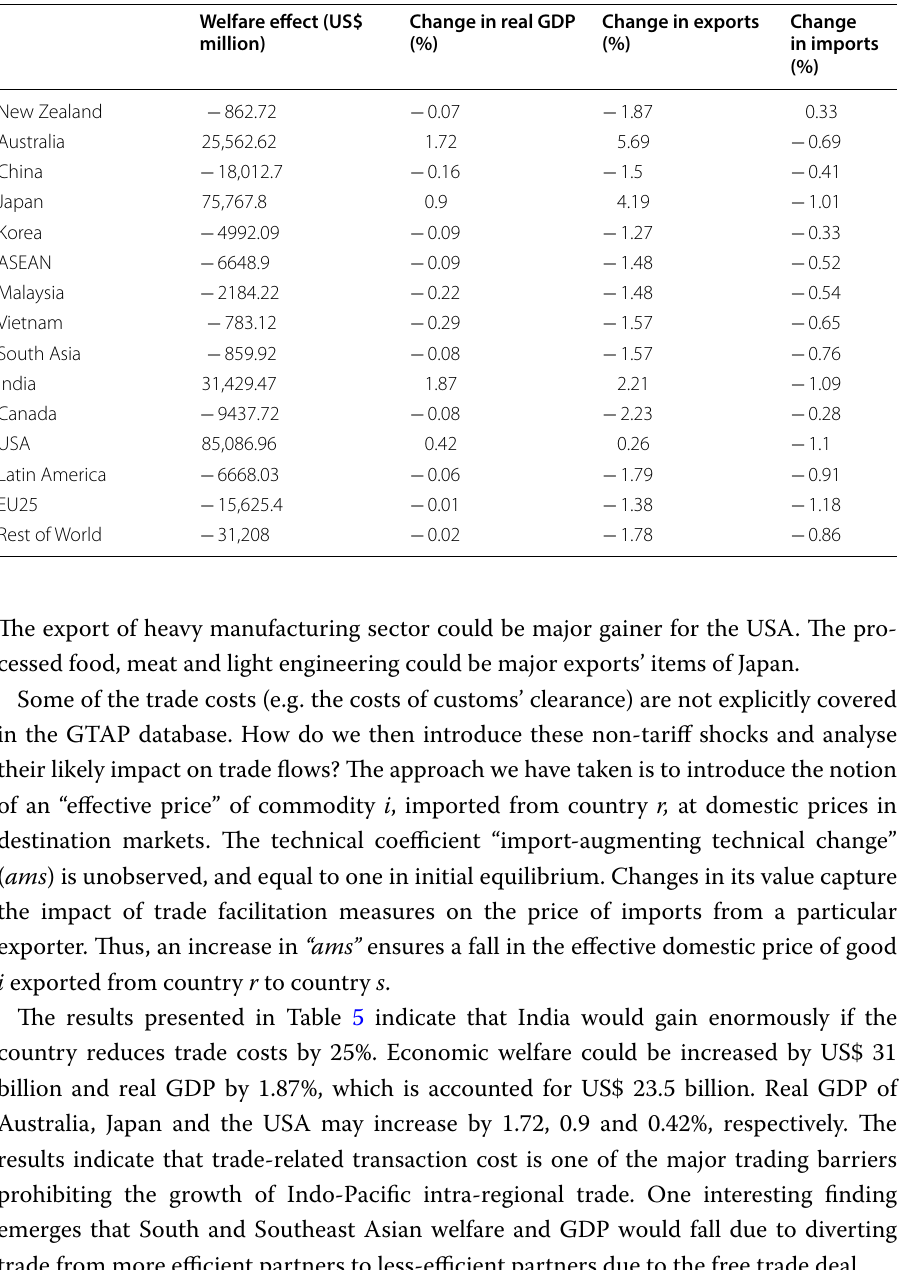
Table 5 Macroeconomic impact of tariff eliminations and 25% increase in trade facilitation under ‘Indo-Pacific 1’. Source: Authors’ simulation from GTAP version